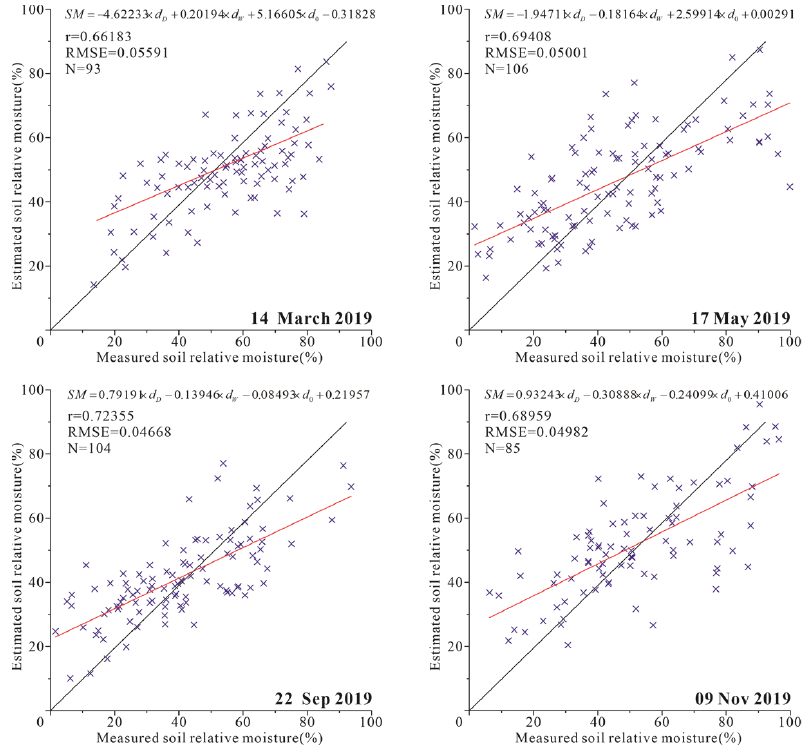
Figure 7. The scatter plot between measured and estimated soil relative moisture at Henan study area. A 1:1 line is added in the plot.